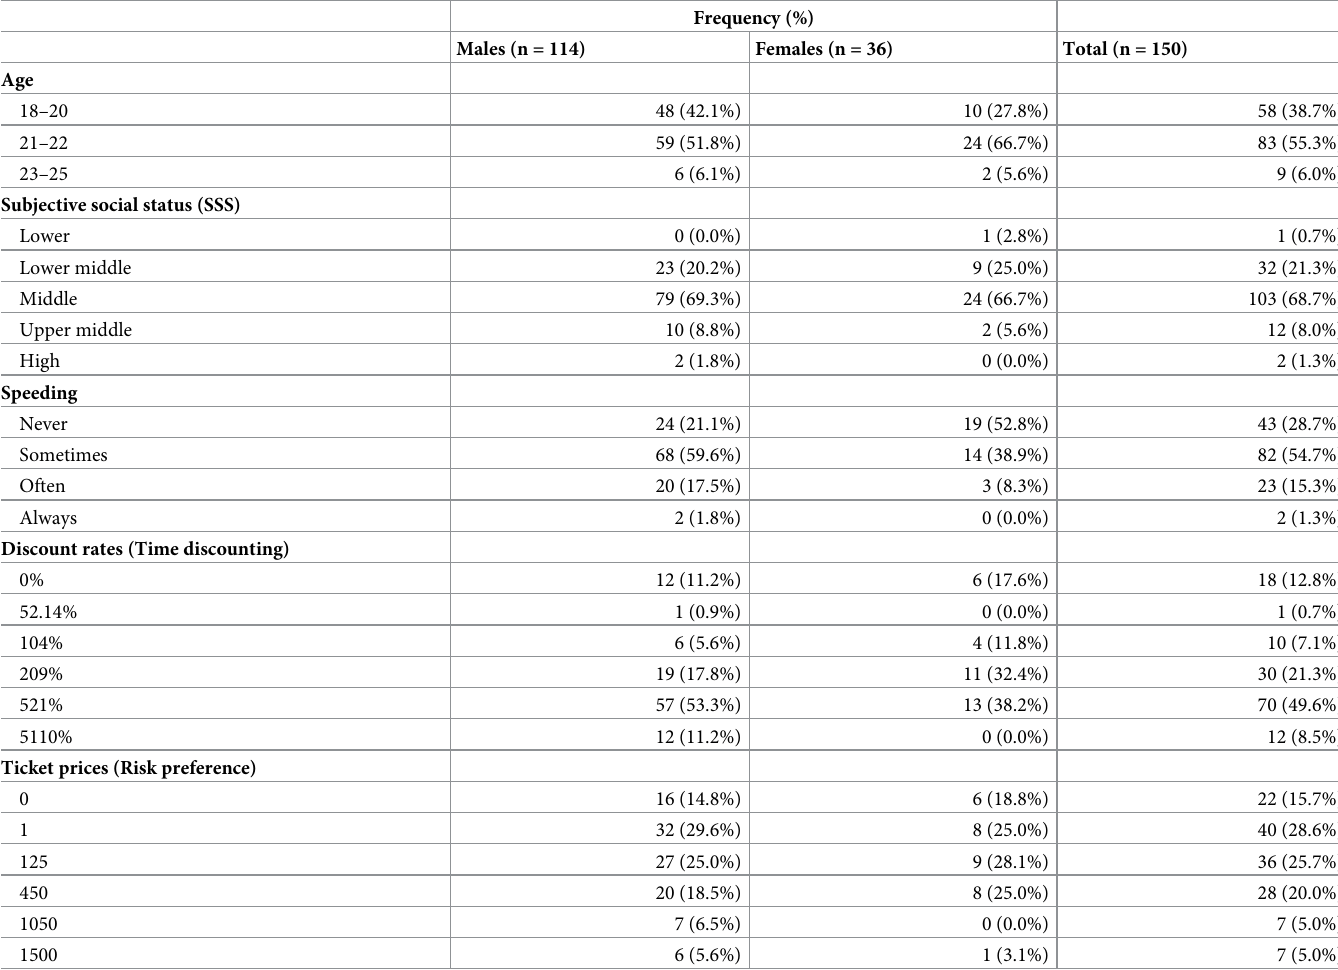
Table 1. Descriptive characteristics of the study participants (N = 150).